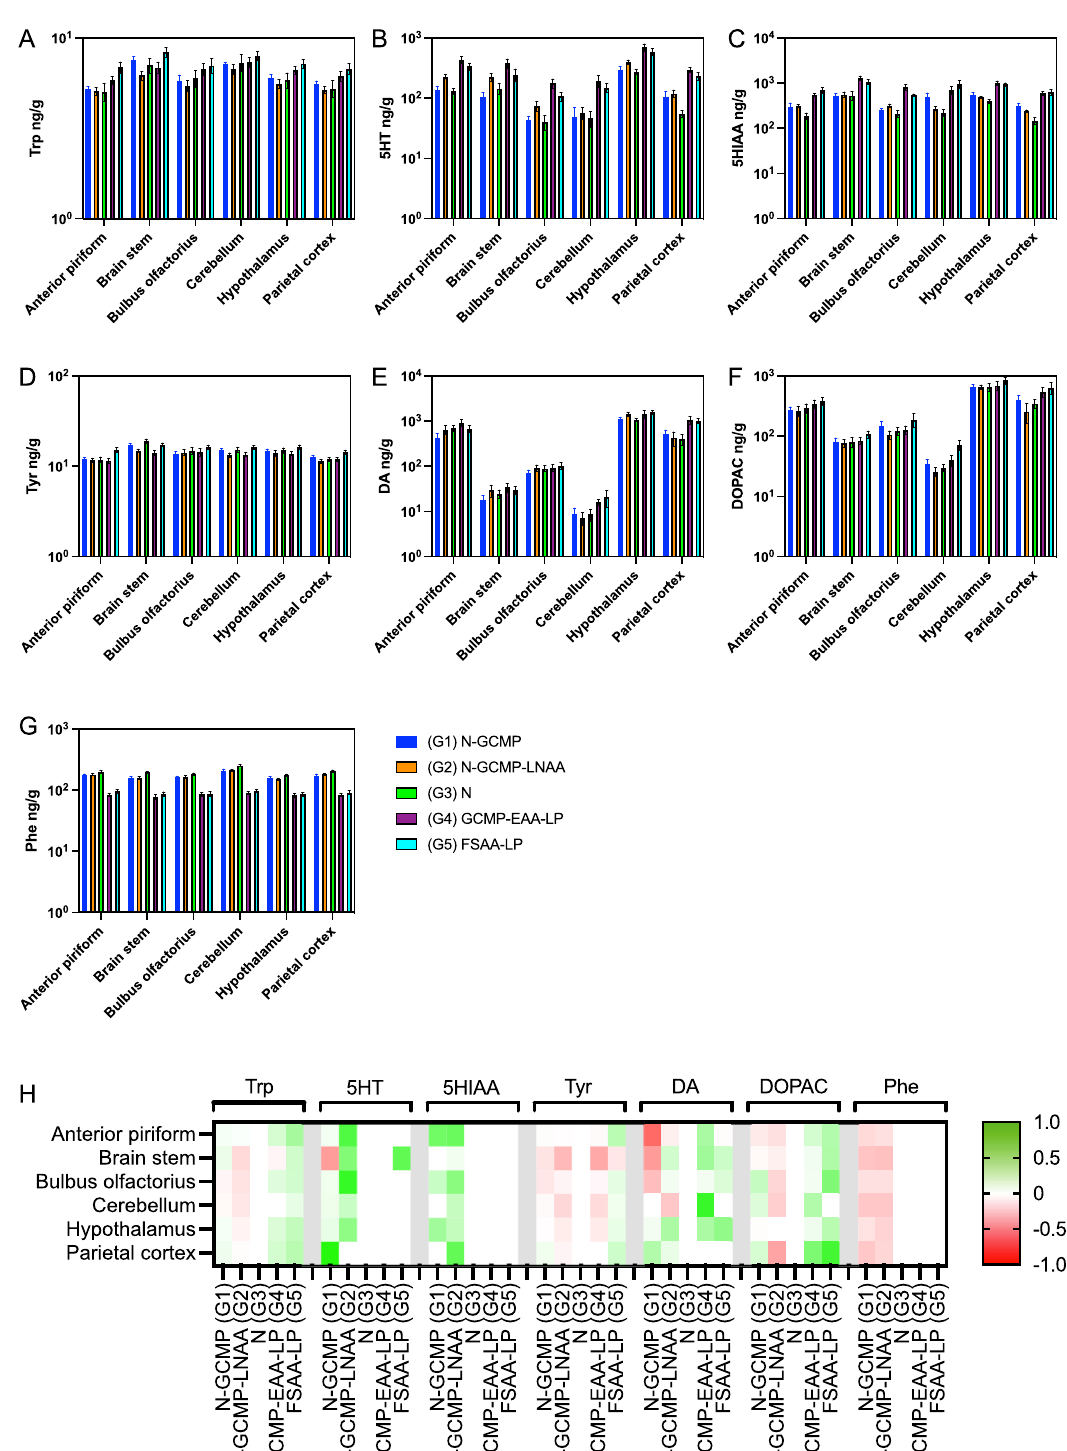
Fig 6. The content of DA, 5-HT, 5-HIAA, DOPAC, Phe, Tyr and Trp in the 5 groups of animals measured separately in the different brain parts; cerebellum, brain stem, hypothalamus, parietal cortex, anterior piriform, cortex and olfactory bulb. Trp is metabolized to 5-HT in the brain and finally further metabolized mainly to 5-HIAA. Tyr is precursor of DA which is further converted to DOPAC.